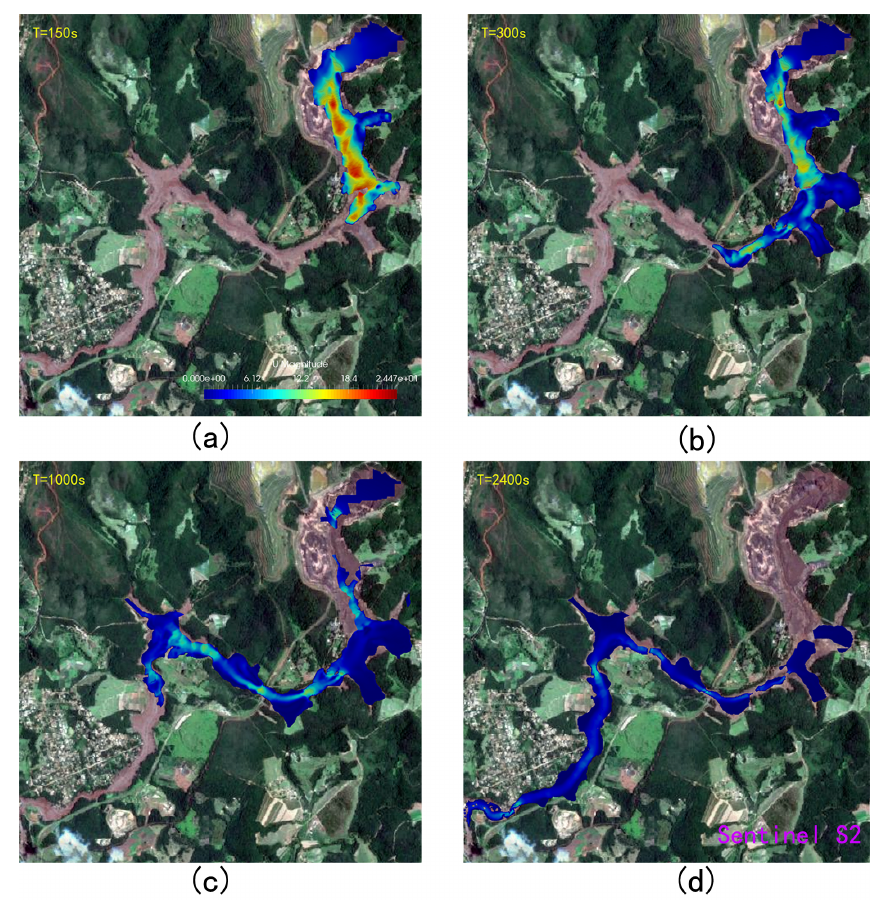
Figure 9. The time sequence of the numerically computed event up to the tailings reaching the Paraopeba River. The base map is the satellite image (Sentinel S2) after the dam break. The color map of the simulation results is mapped by velocity characteristics.